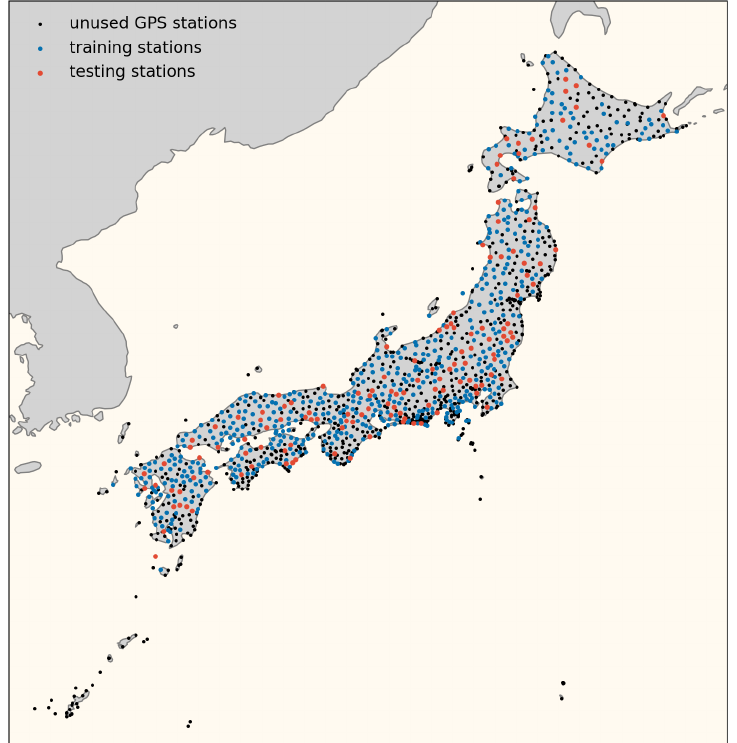
Figure 2. Map of Japan showing the majority of all available GPS stations in Japan as well as the training and testing stations of the suitable station subset that are used in the